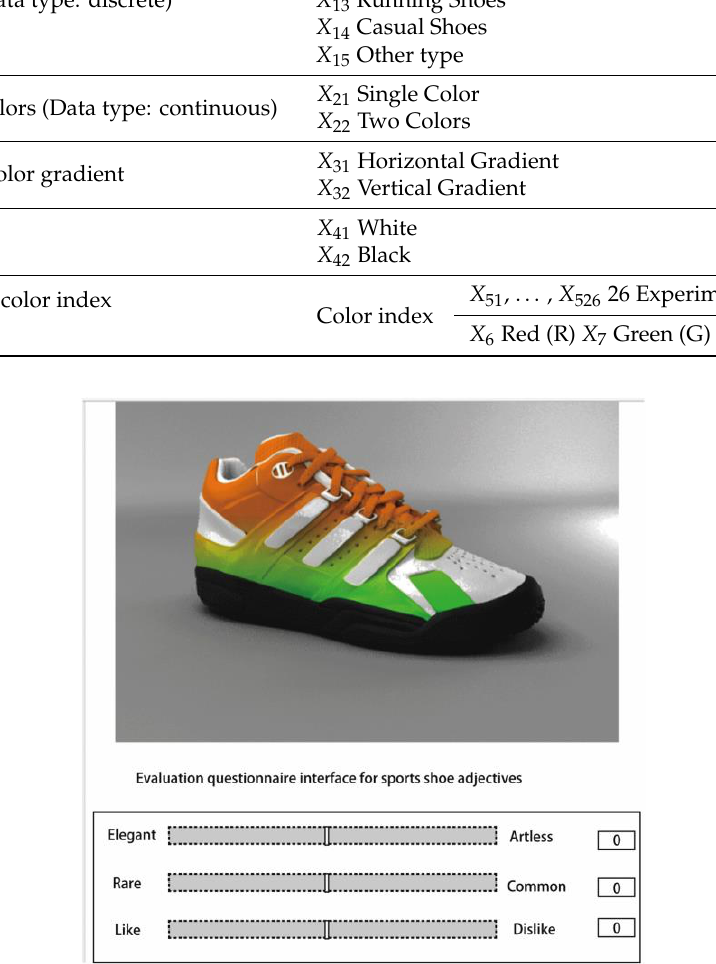
Figure 1. Interface of web-based questionnaire for adjective evaluation.